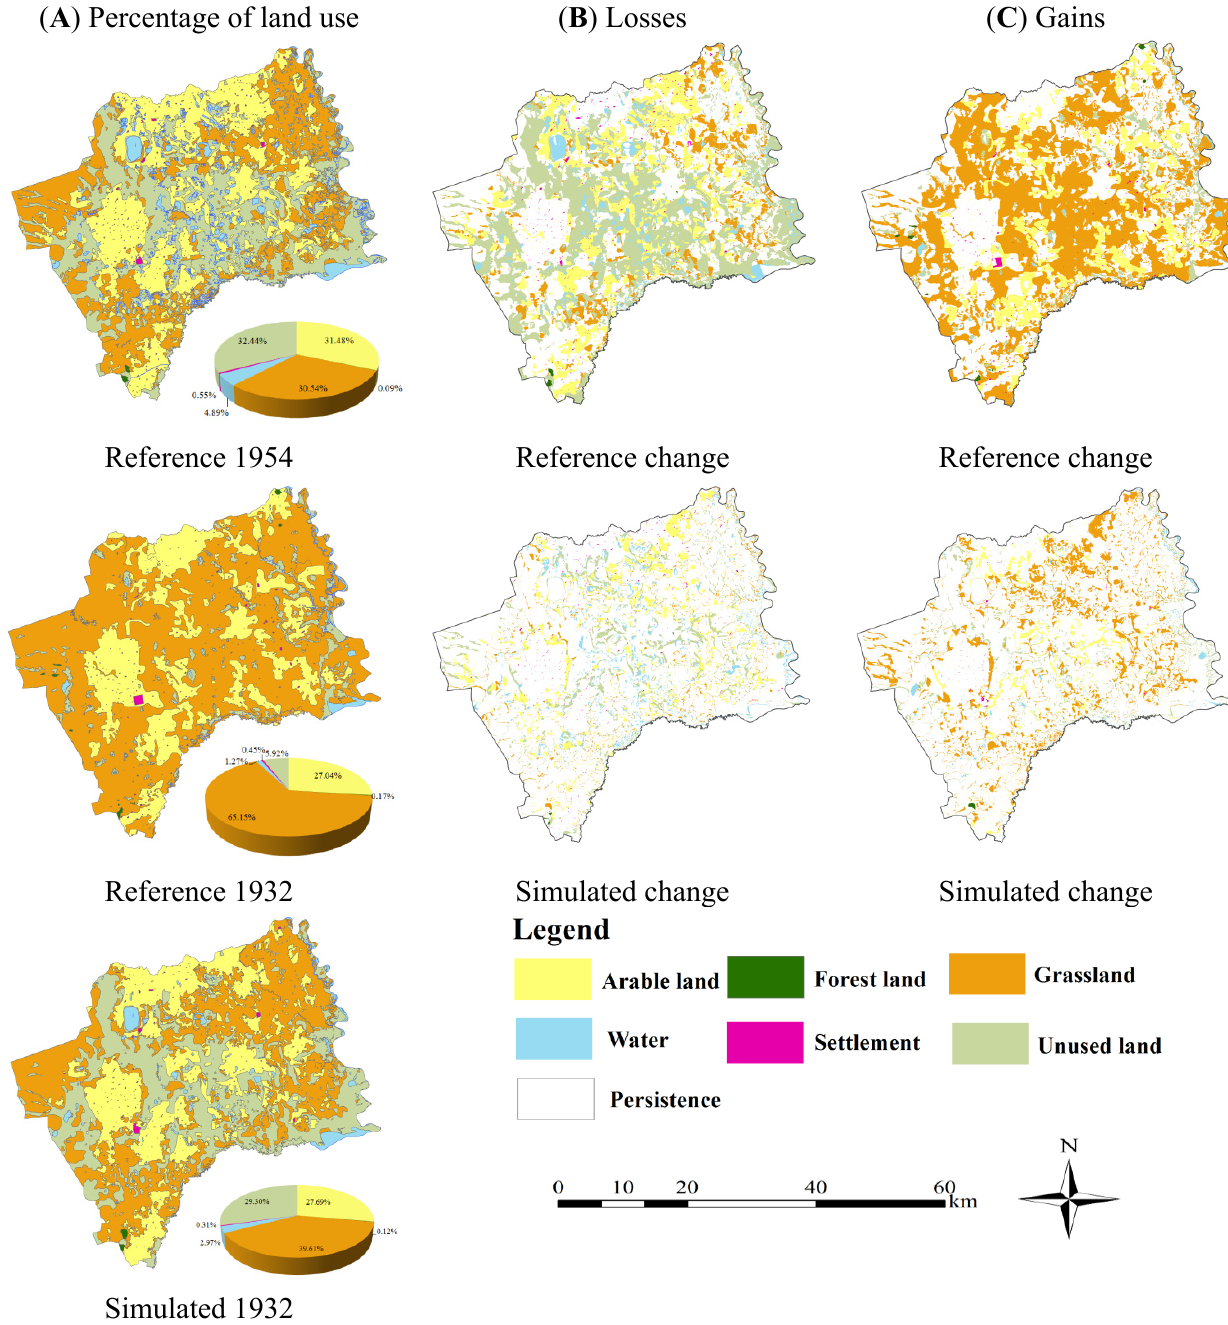
Figure 7. Percentage of land categories at three time points and changes during two time intervals in Zhenlai